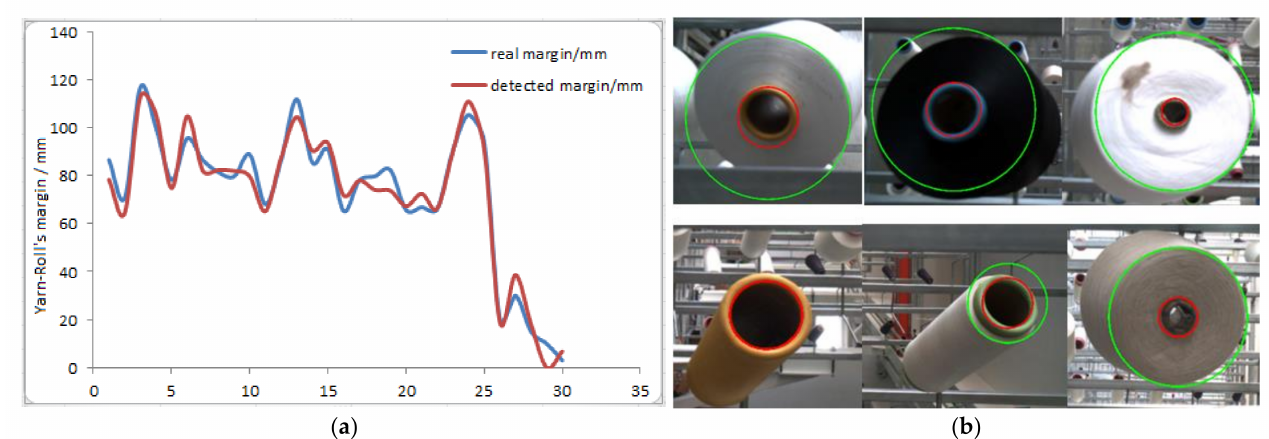
Figure 13. ( a ) The fused results. Blue line is the real margin and the red line is the detected line. ( b ) This is the measured values drawn in image.